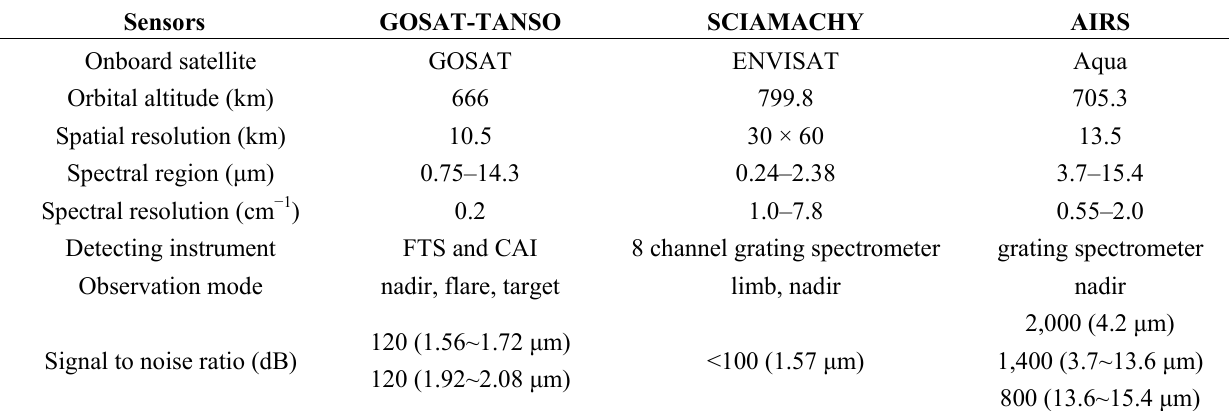
Table 1. The satellite sensors performance parameters of Greenhouse Gases Observing Satellite (GOSAT), Scanning Imaging Absorption Spectrometer for Atmospheric Cartography (SCIAMACHY) and Atmospheric Infrared Sounder (AIRS). TANSO, Thermal and Near-infrared Sensor for Carbon Observation; FTS, Fourier Transform Spectrometer; CAI, Cloud and Aerosol Imager; ENVISAT, Environmental